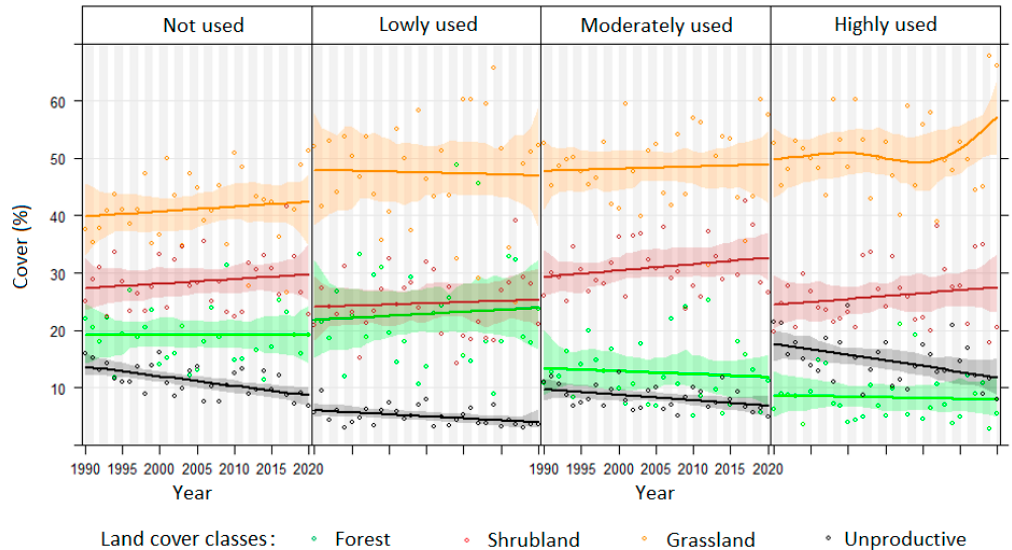
Figure 6. Temporal evolution (1990–2020) of the cover of the different land cover classes in the merino passes grouped according to the time of use by sheep (not used, lowly used, moderately used, and highly used). The dots indicate the mean values for each year, the line predicted values by generalized additive models, and the shading of the 95% confidence interval.